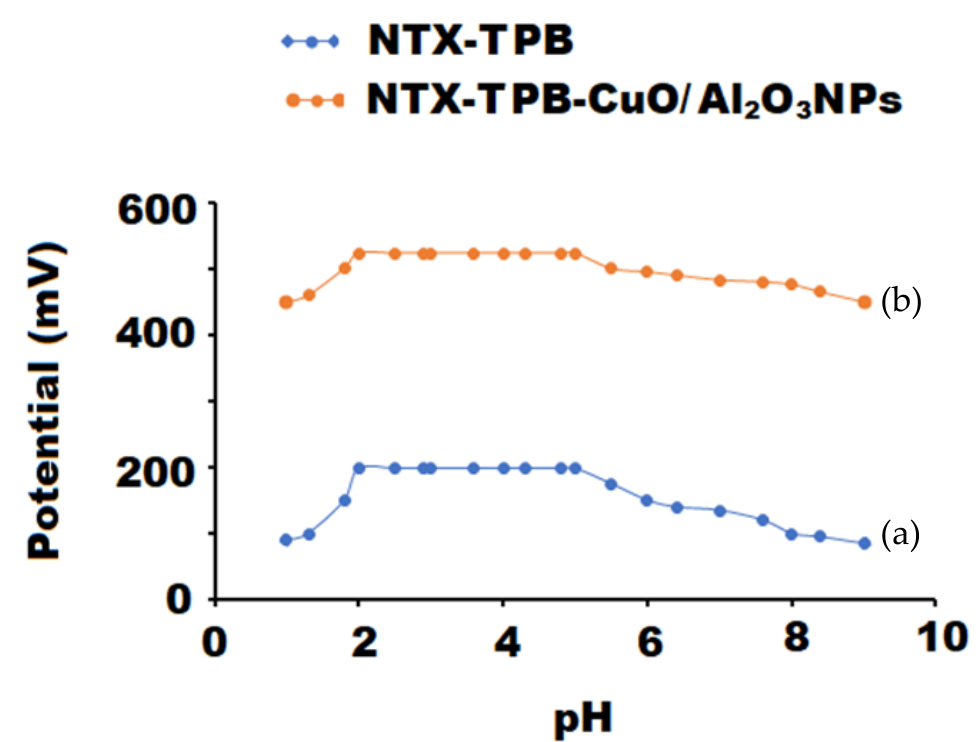
Figure 9. pH range of each constructed Conventional ( a ) NTX-TPB and ( b ) NTX-TPB-CuO/Al 2 O 3 nanocomposite coated wire sensors using 1.0 × 10 − 4 mol L − 1 of NTX solution. Table 2. The tolerable values of some foreign substances and co-formulated materials measured by the designed